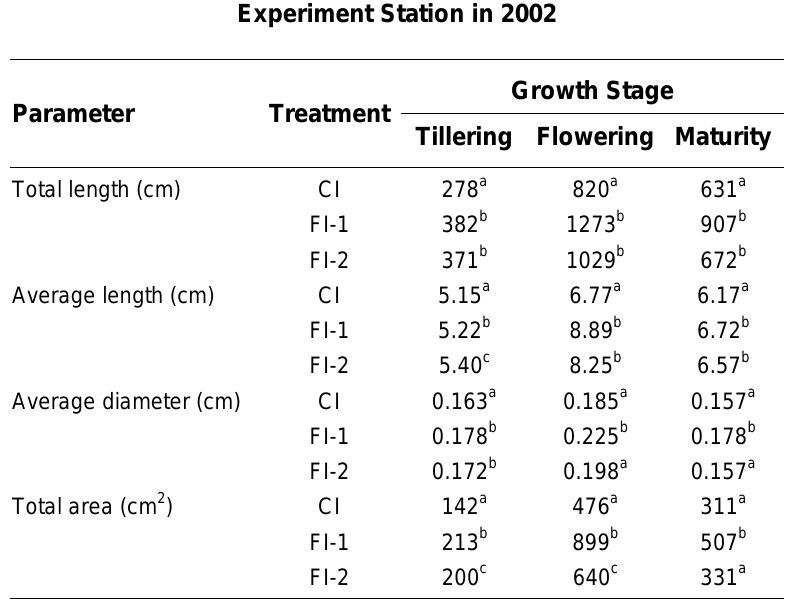
Characteristics of the Root System in the CI, FI-1, and FI-2 Treatments Conducted at Guandong Ocean University